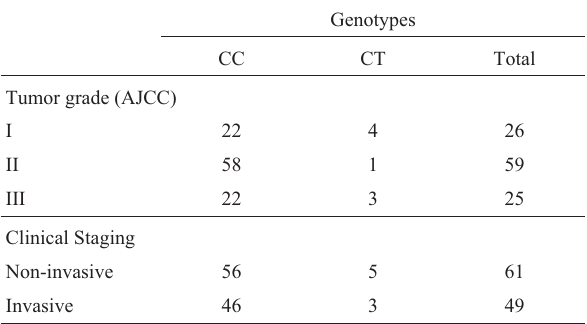
Table 2 - Genotype frequencies of 3’-UTR T/C polymorphism of the urokinase gene in patients with bladder cancer, according to pathological grading and clinical